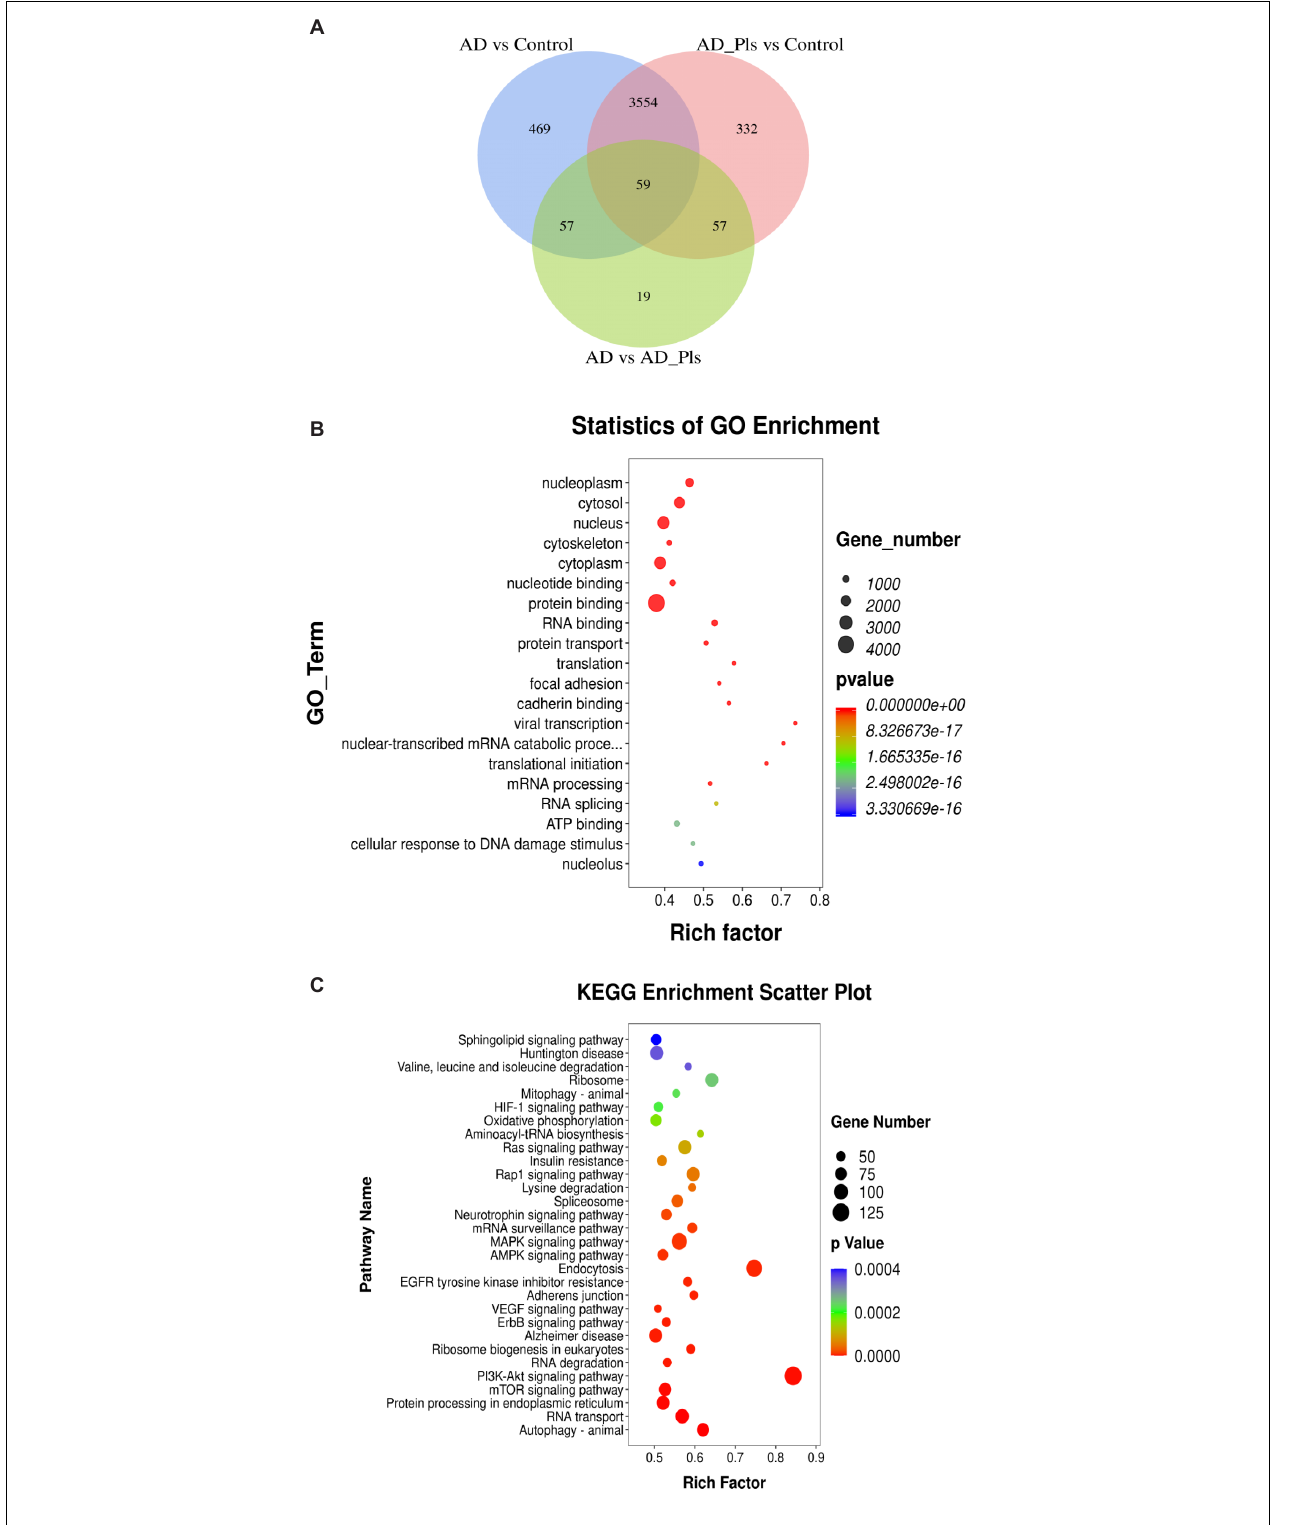
FIGURE 2 | Numbers of DEGs between experimental groups, and their corresponding GO and KEGG enrichment data. (A) Venn diagram showing the DEGs significantly identified by comparison of AD model and control groups, AD model + Pls and control groups, and AD model and model + Pls groups (fold change > 2 or fold change < 0.5). (B) GO function enrichment analysis of DEGs. (C) KEGG pathway enrichment analysis of DEGs.